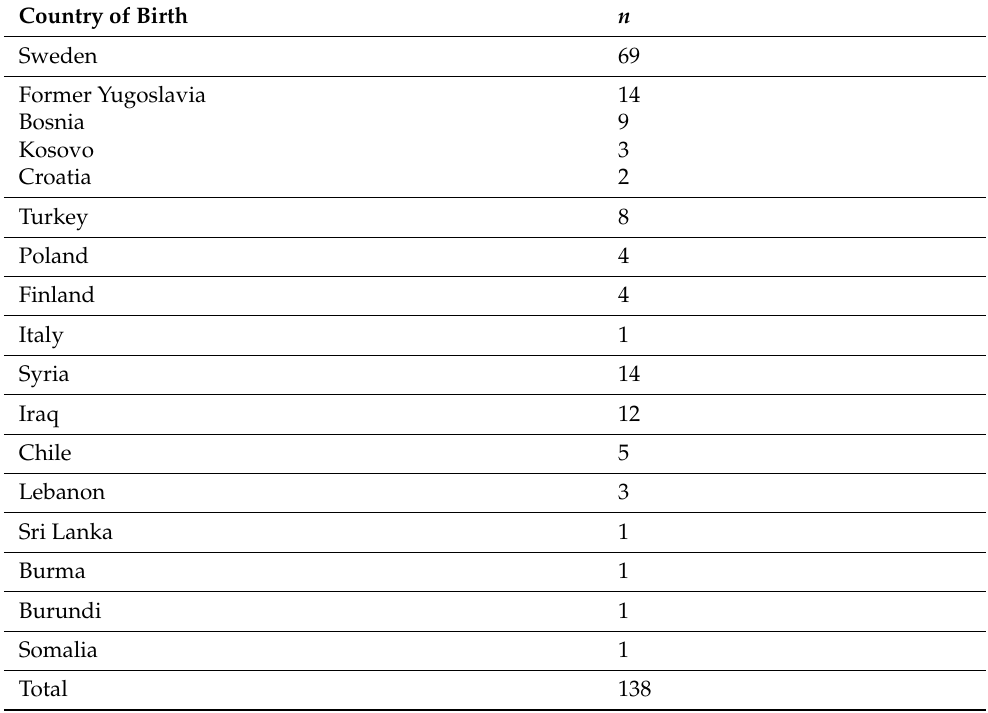
Table 2. Country of birth of the study population among migrants and Swedish-born persons with type 2 diabetes living in